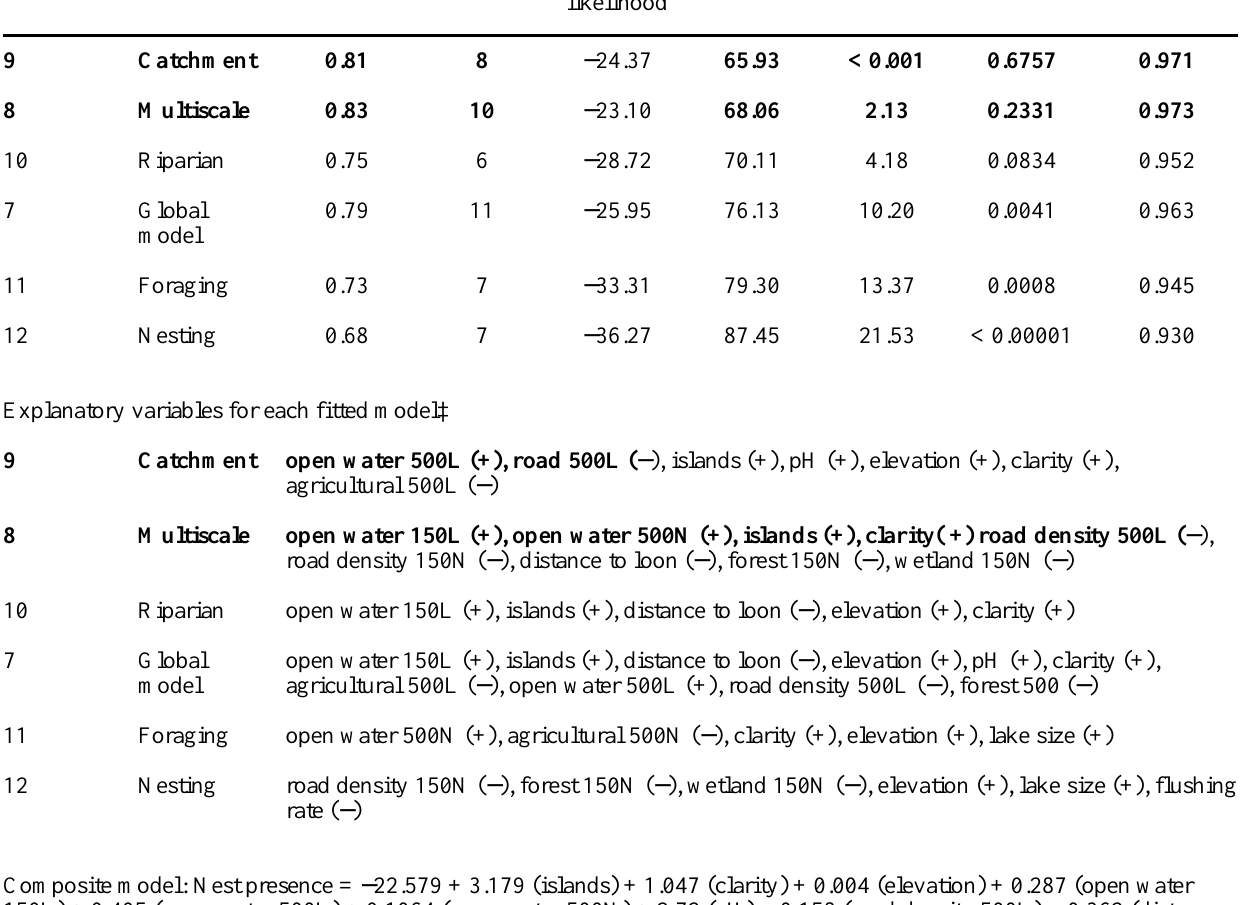
£ 2, are indicated c